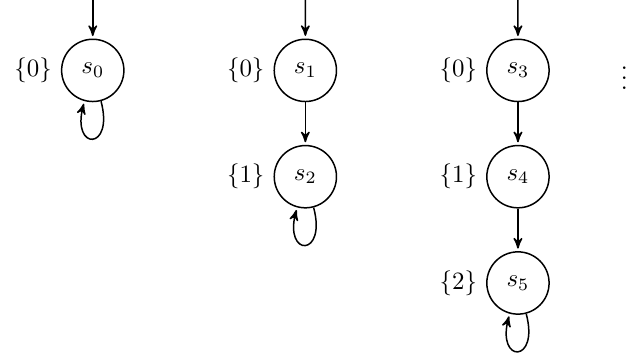
Figure 3. Kripke structure of the program P4 .